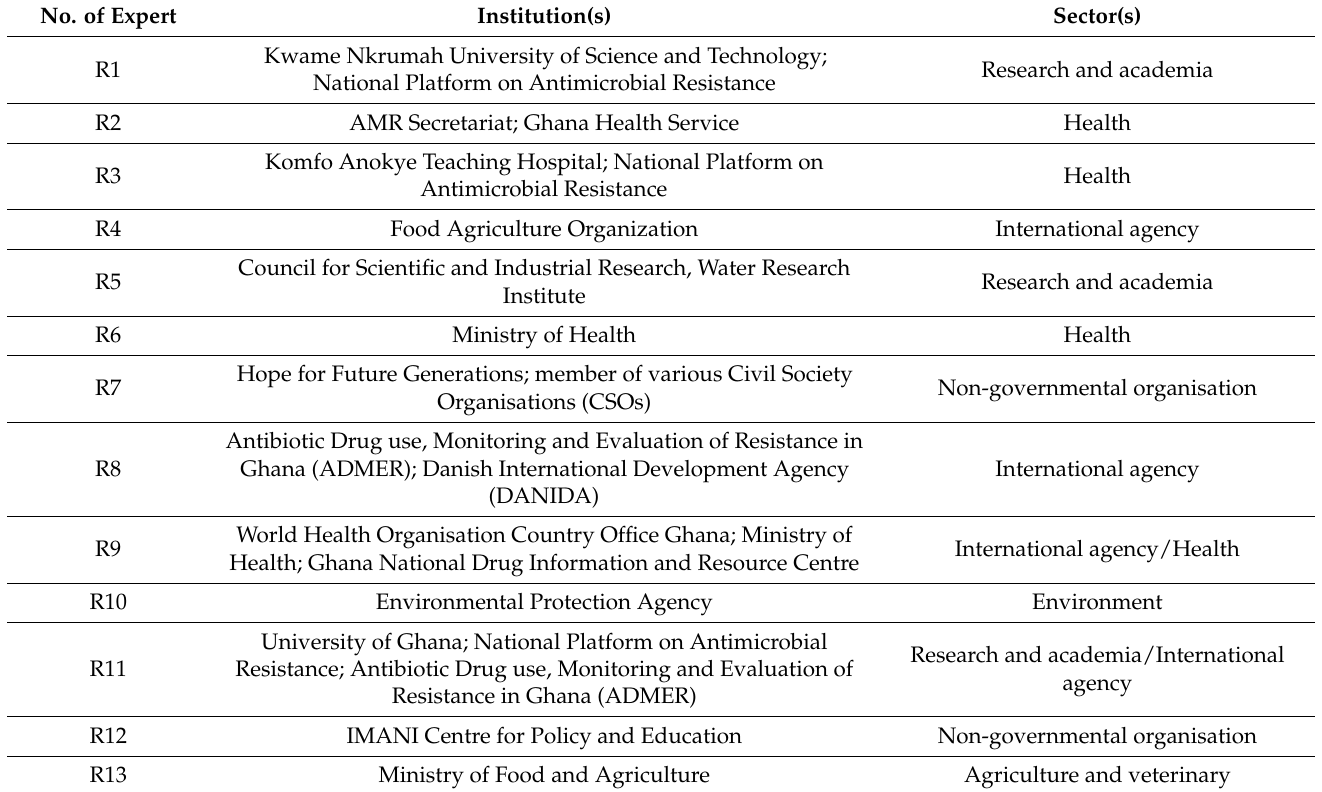
Table 2. Affiliation of interviewed